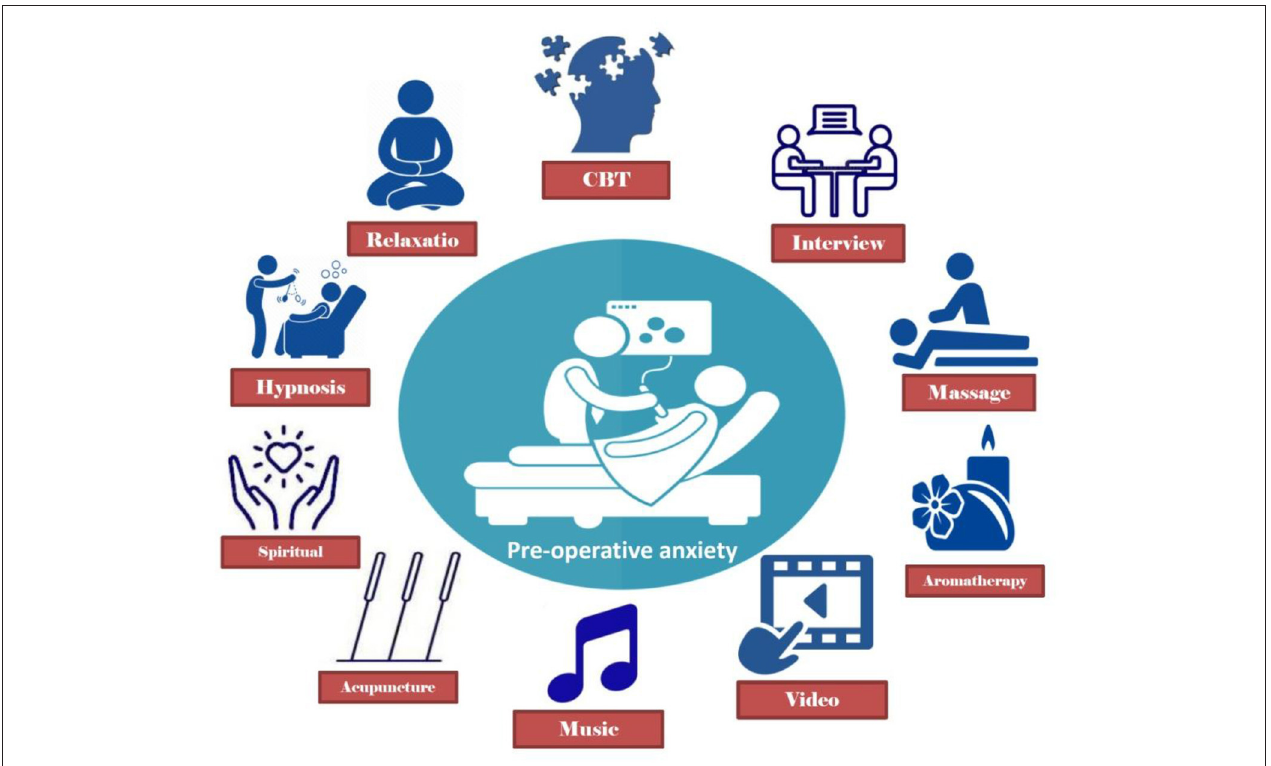
FIGURE 1 | Non-pharmacologic approaches in preoperative